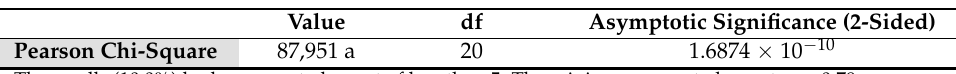
Table 21. Chi-square tests.